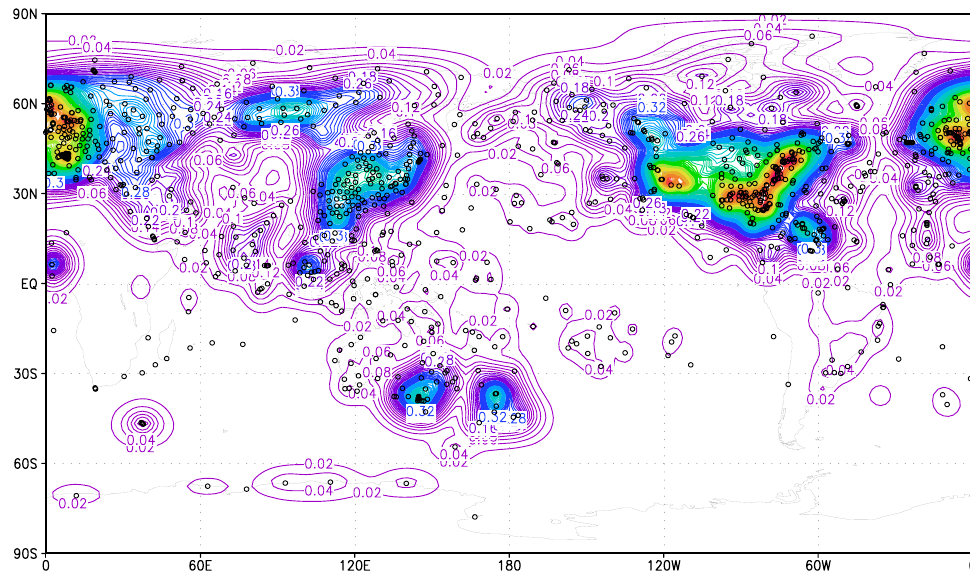
Fig. 12. The same as Fig. 11, but for relative humidity q